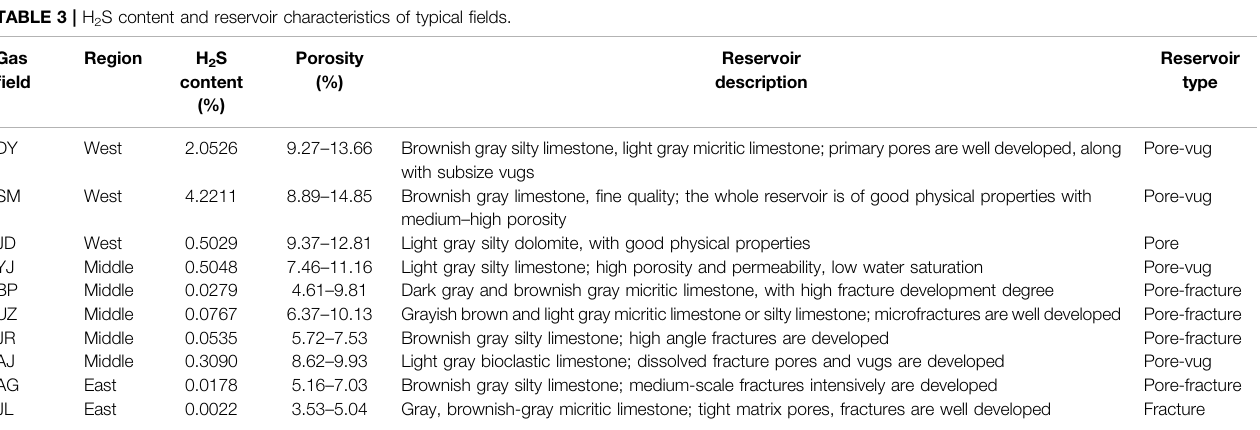
TABLE 3 | H 2 S content and reservoir characteristics of typical fi